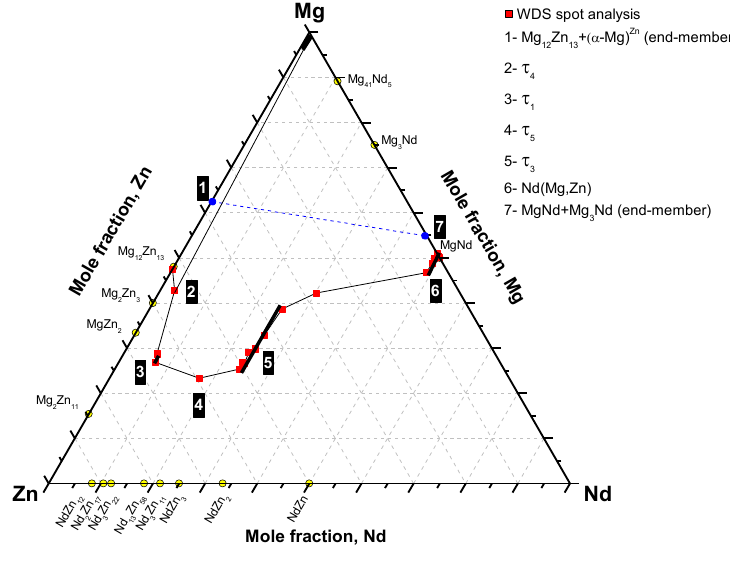
Figure 7. The phase equilibria depicted from diffusion couple